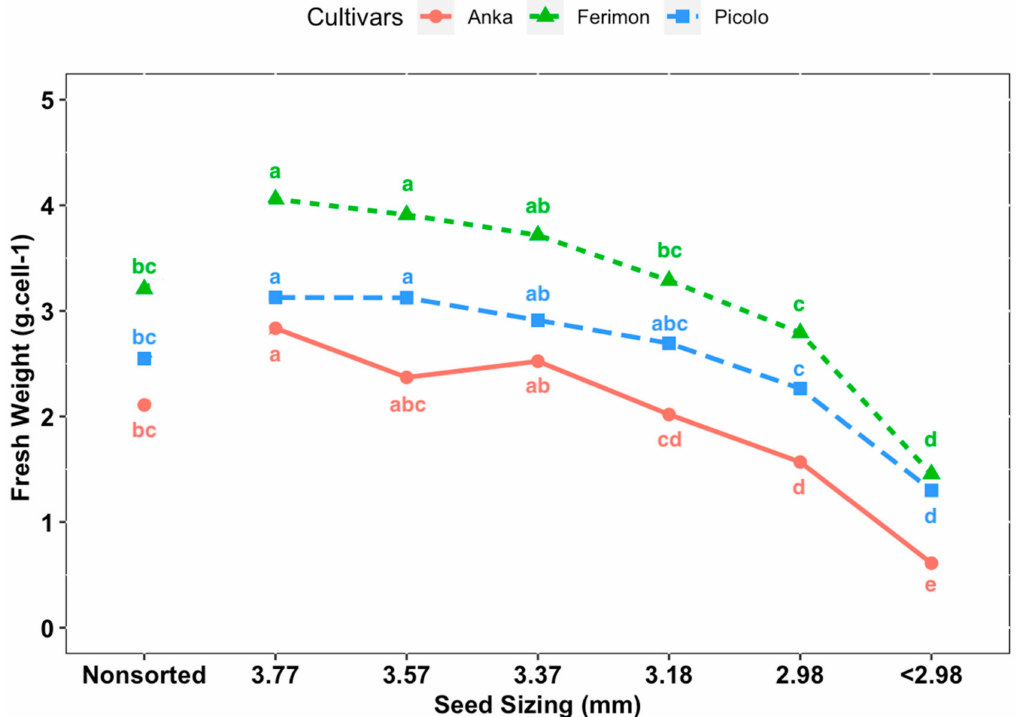
Figure 8. Fresh weight of baby leaf hemp cultivars ‘Anka’, ‘Ferimon’ and ‘Picolo’ in response to seed size treatment. Data represent mean of 15 experimental units (3 crop cycles each with 5 experimental units per treatment). Letters represent mean separation comparison using Tukey’s HSD (alpha =